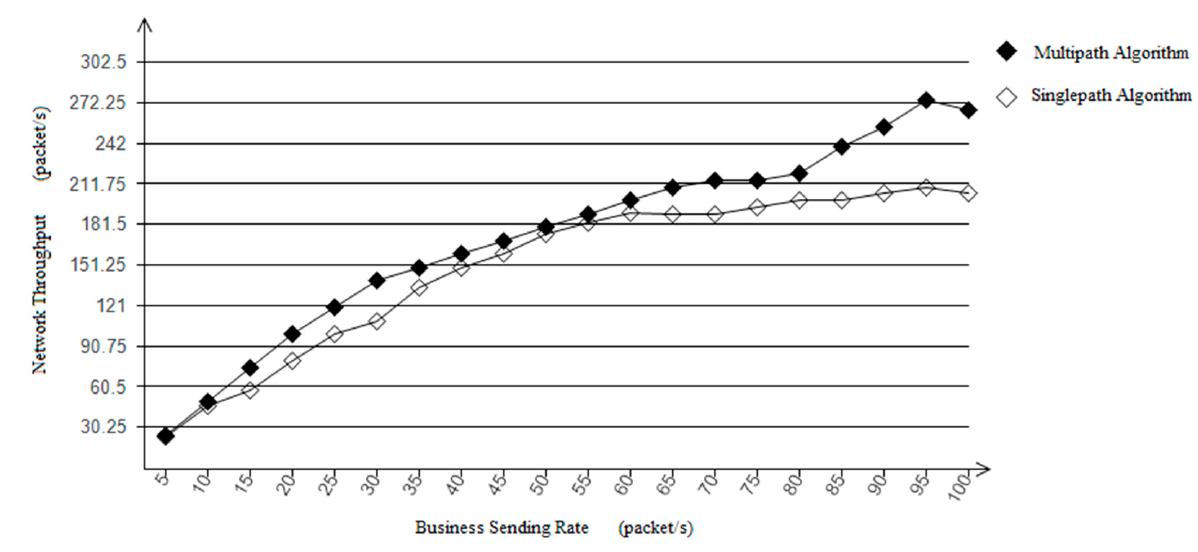
Figure 10. Network Throughput Comparison Chart.